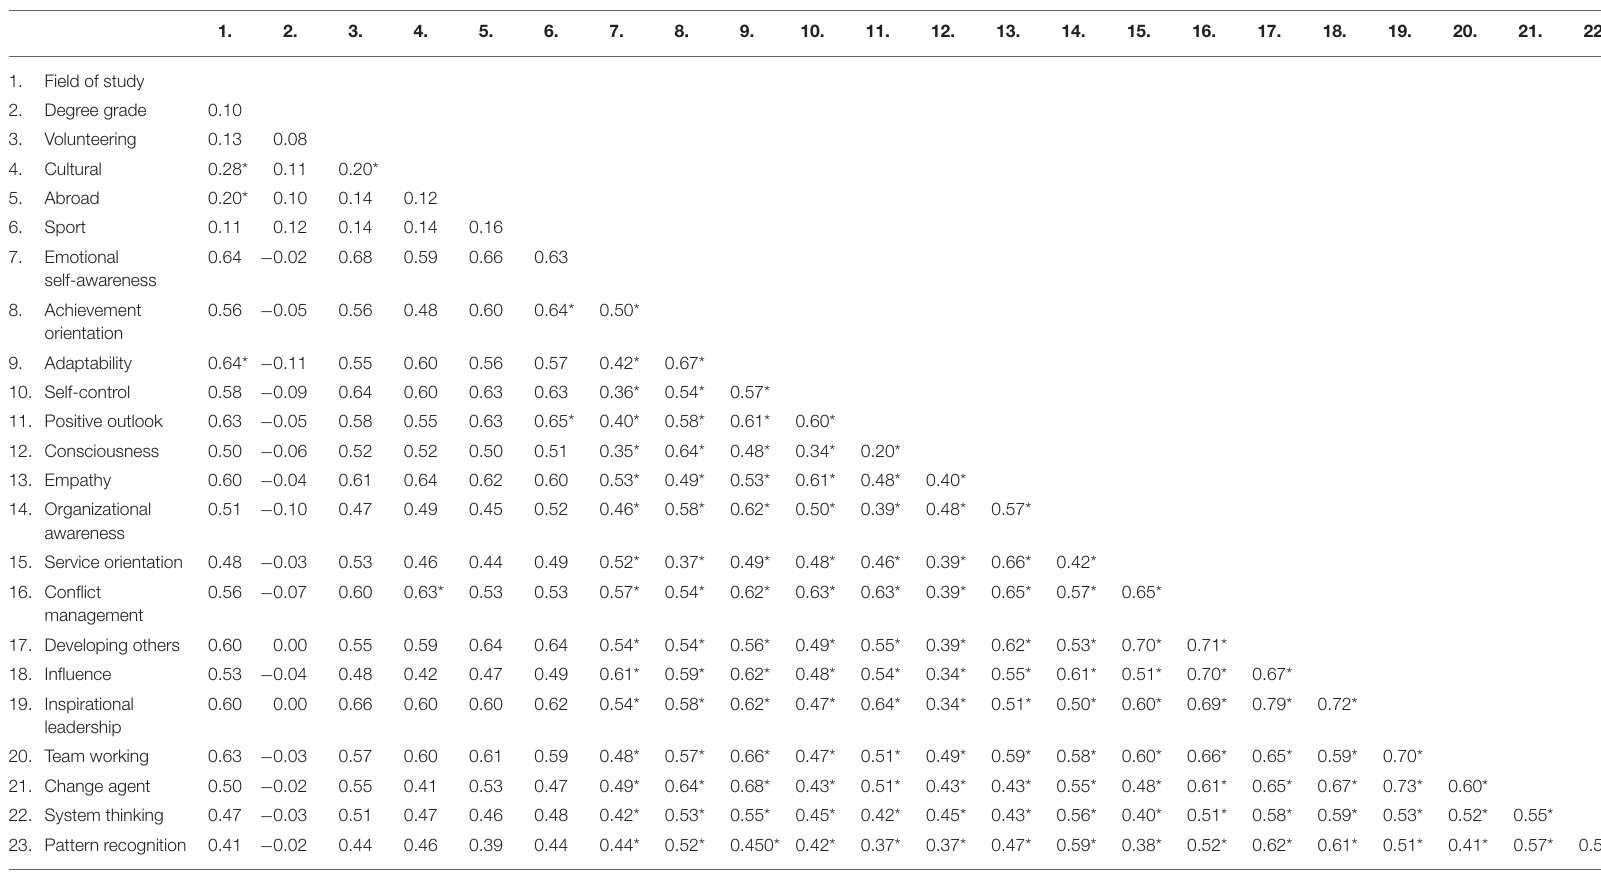
TABLE 2 | Correlations between main